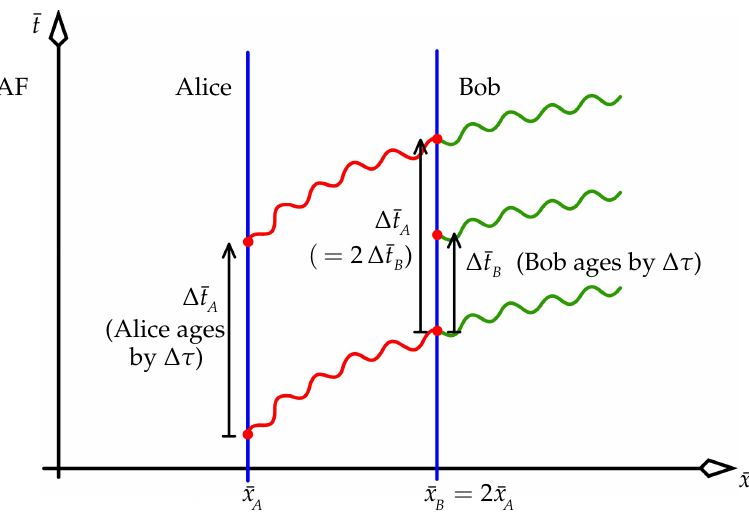
Figure 10. Eddington’s correct calculation of the redshift. He compared the lapses in coordinate time ( ∆ ¯ t , ∆ ¯ t ) for one given proper time ∆ τ elapsing for both Alice and Bob. Alice and Bob’s clocks are A B identical: they both have the same proper period of ∆ τ ; but Bob ages twice as fast than Alice, and so he ages ∆ τ in half the coordinate time taken by Alice. If, like Alice, Bob sent a light ray upwards at each tick of his clock ( ∆ τ ), he would emit twice as many light rays as does Alice per unit coordinate time, as shown in